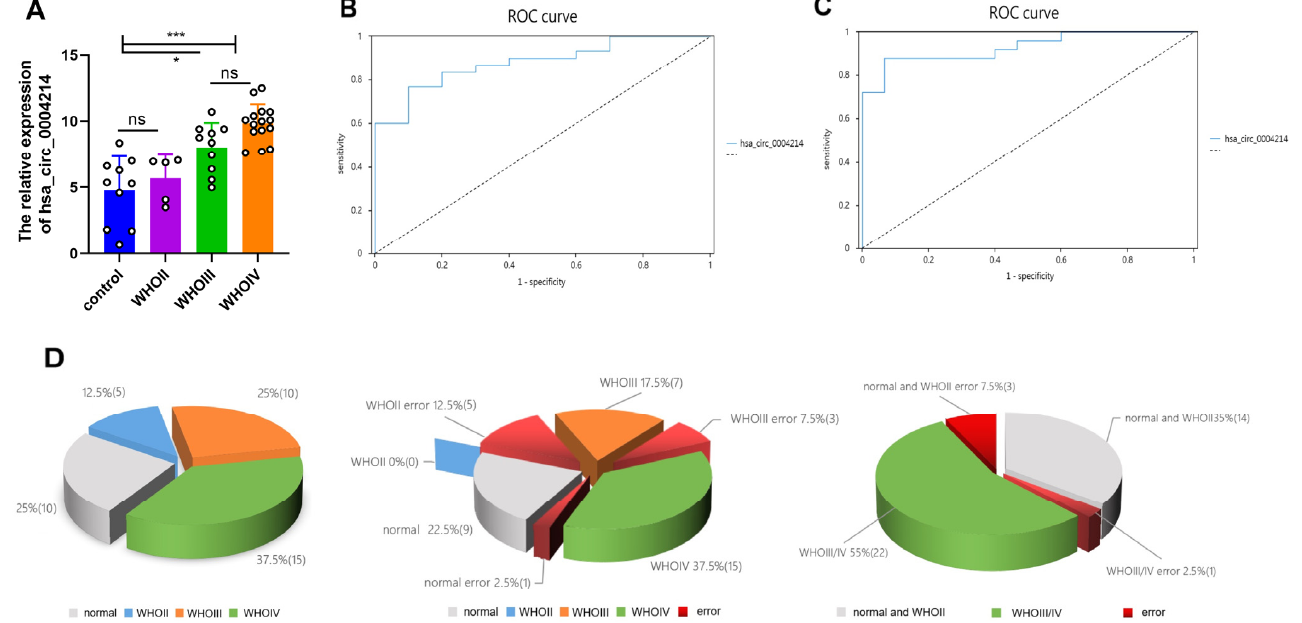
Figure 3. Expression level and diagnostic value of hsa_circ_0004214 in different grades of glioma. ( A ) Expression level of hsa_circ_0004214 in different grades of glioma (* p < 0.05, *** p < 0.005). ( B ) hsa_circ_0004214 distinguishes non-glioma brain tissue from control group and glioma tissue, and its ROC curve. ( C ) hsa_circ_0004214 distinguishes low-grade glioma (control + WHO II) and high-grade glioma (WHO III/IV), and its ROC curve. ( D ) Evaluation of data for different diagnostic categories via pie charts. The frequency of diagnostic success and error were recorded, respectively.